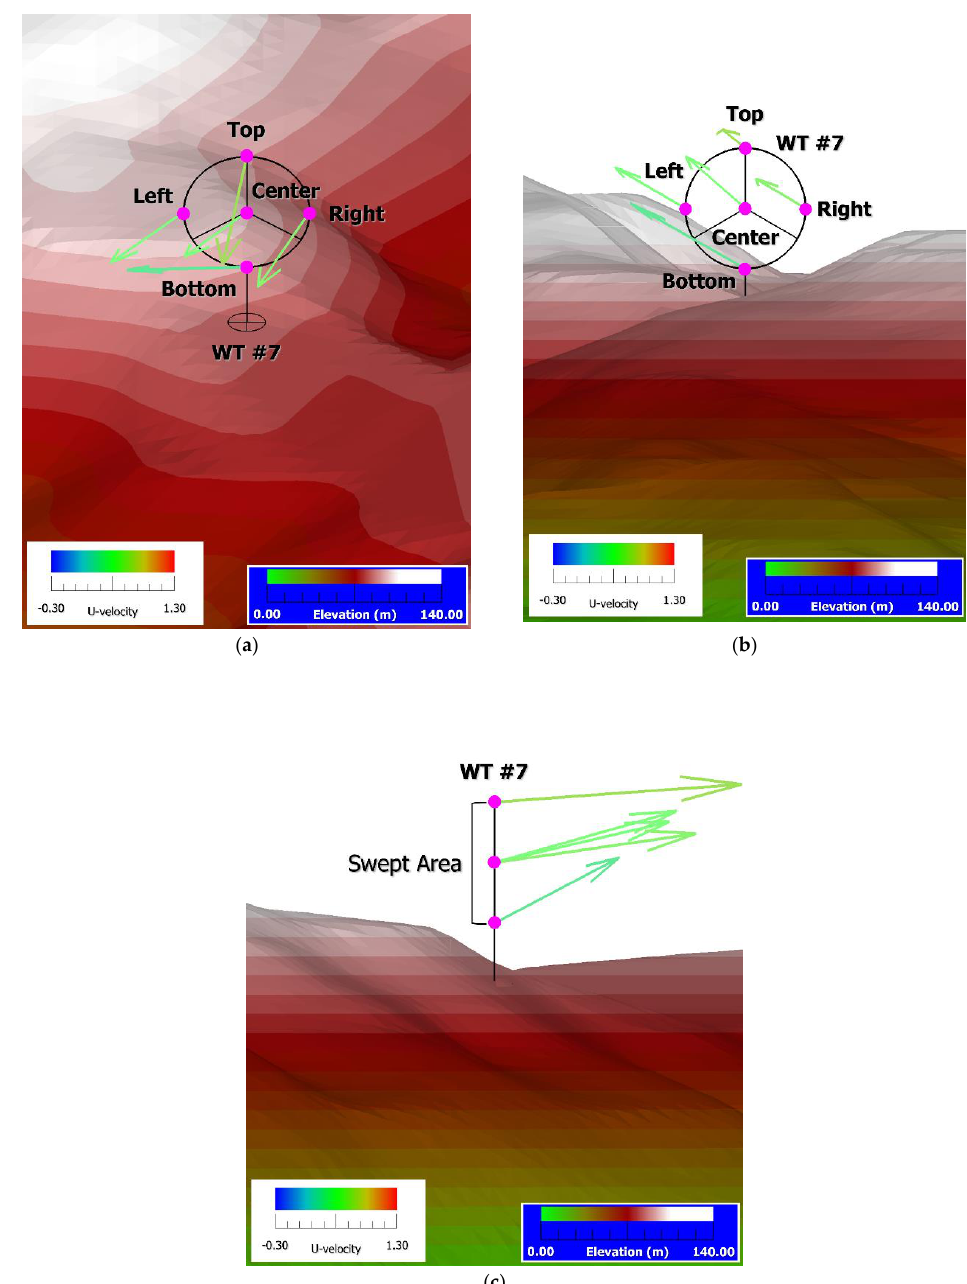
Figure 25. Vertical distribution of time-averaged velocity vectors at WT #7 for north-westerly wind: ( a ) Rear view from slightly above, ( b ) rear view, and ( c ) side view. This flow visualization is based on the numerical results using a 5 m grid.